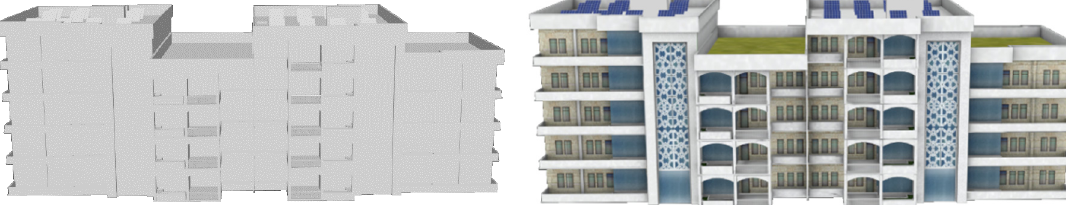
Figure 9. A close-up view of building model before texturing ( left ) and after texturing ( right ).